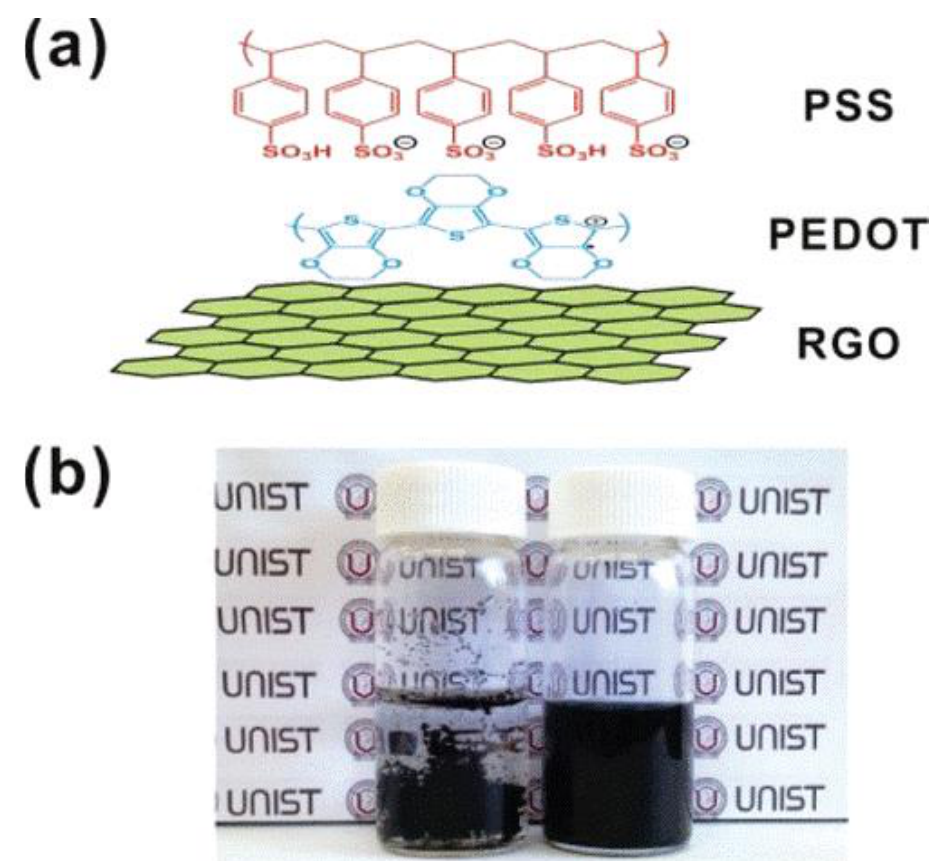
Figure 9. ( a ) Schematic representation of reduced graphene oxide (RGO) nanosheet with PEDOT:PSS. ( b ) Image of thin film of RGO/PEDOT deposited on a flexible PET substrate with a transmittance of 90%. Reproduced from [45], copyright 2011, with permission from the American Chemical Society.